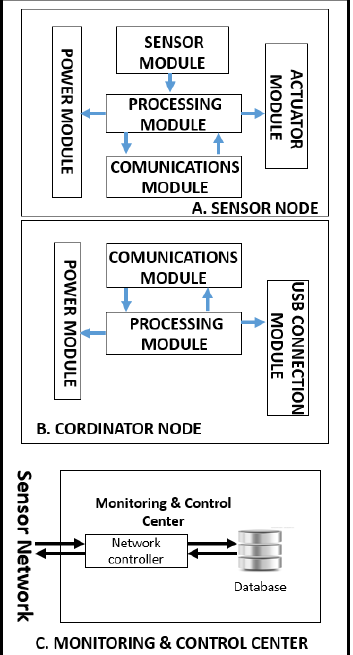
Figure 2. System Architecture.